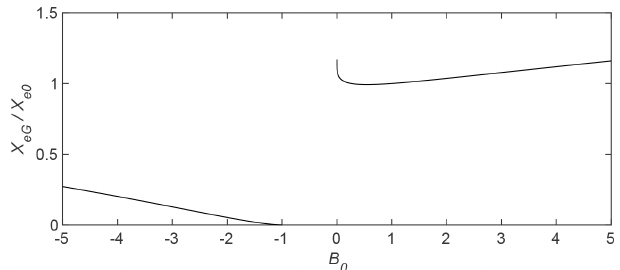
Figure 1. X eG /X eO as a function of B 0 for the three Gardner soli-